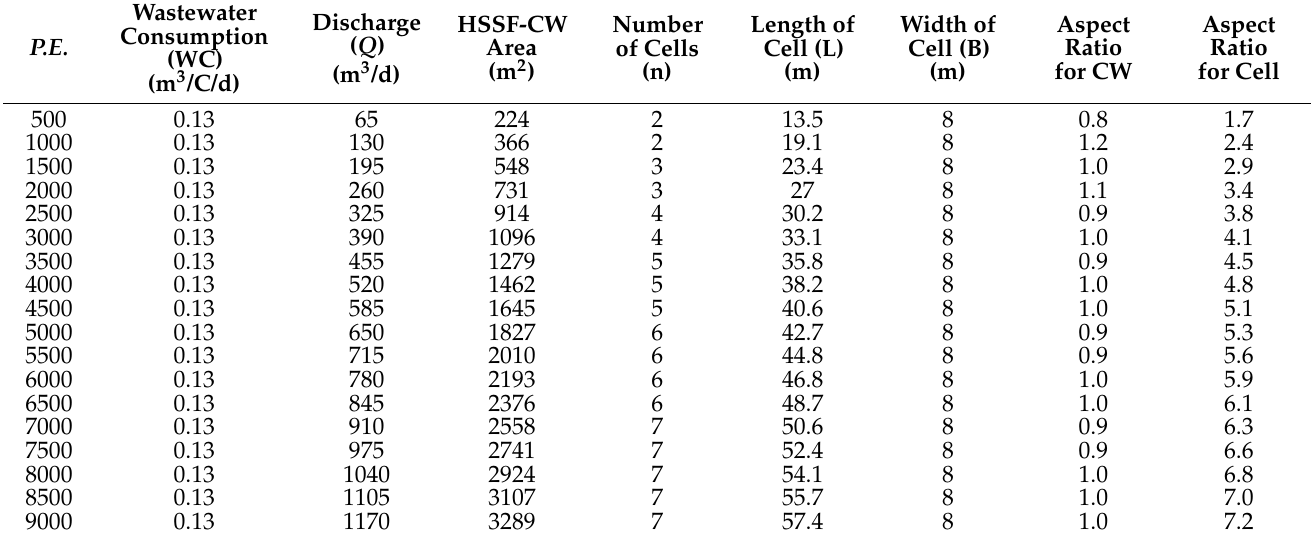
Table 6. VF-CW design dimensions for discharge range of 65-1170 m 3